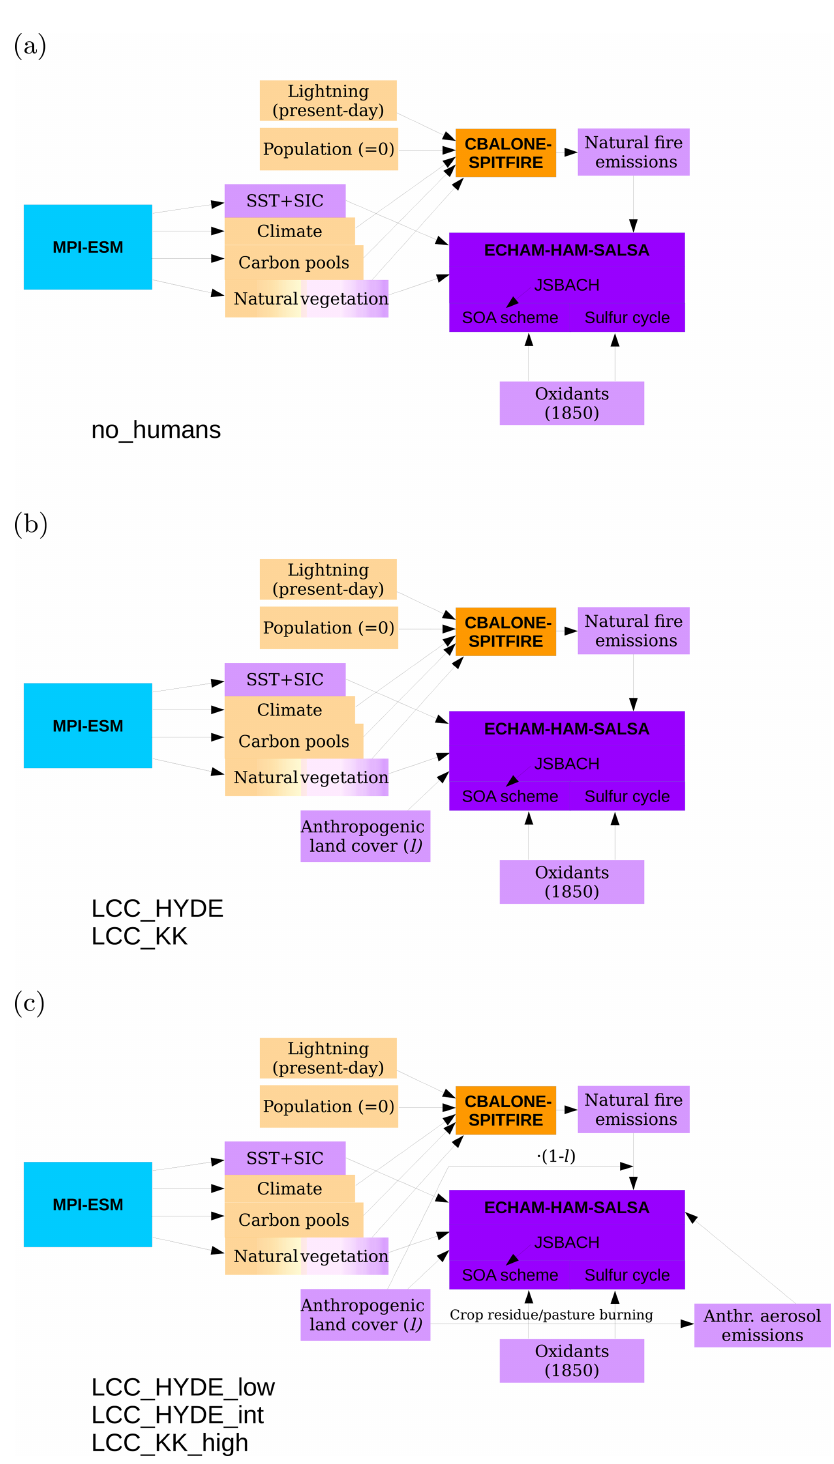
Figure 1. Illustrated are the setups of the six simulations conducted with ECHAM-HAM-SALSA (no_humans, LCC_HYDE, LCC_KK, LCC_HYDE_low, LCC_HYDE_int, and LCC_KK_high). Models that we used are shown in dark colours, whereas inputs to these models are shown in light colours. ECHAM-HAM-SALSA (violet) includes (among other components) the vegetation model JSBACH, a secondary organic aerosol scheme, and a sulfur cycle. Natural fire emissions were calculated with CBALONE–SPITFIRE (orange). For driving the two models, output from the Earth system model MPI-ESM was used (blue; simulations come from the study by Bader et al., 2019) among